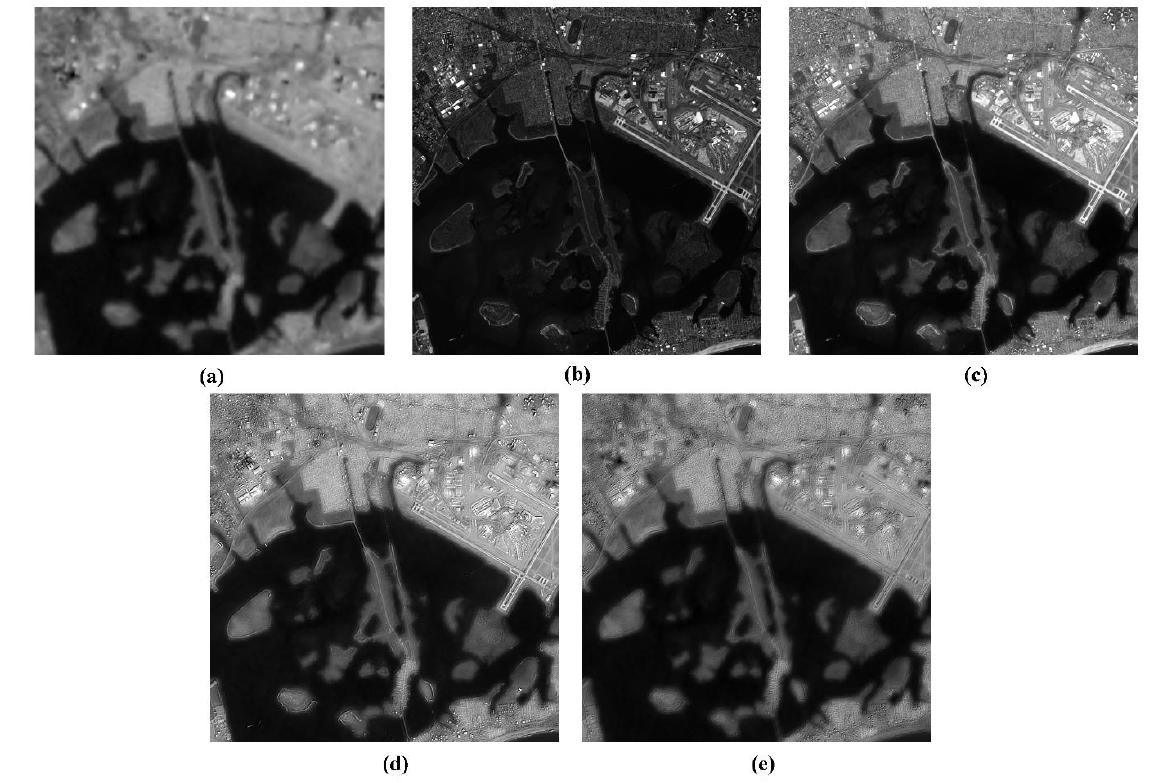
Figure 13. Experimental results of different fusion algorithms on Landsat9 data: ( a ) Landsat9 thermal infrared band image resolution of 100 m; ( b ) Landsat9 panchromatic band image resolution of 15 m; ( c ) fusion results of OSF algorithm; ( d ) fusion results of SRT algorithm; ( e ) experimental results of our proposed algorithm.